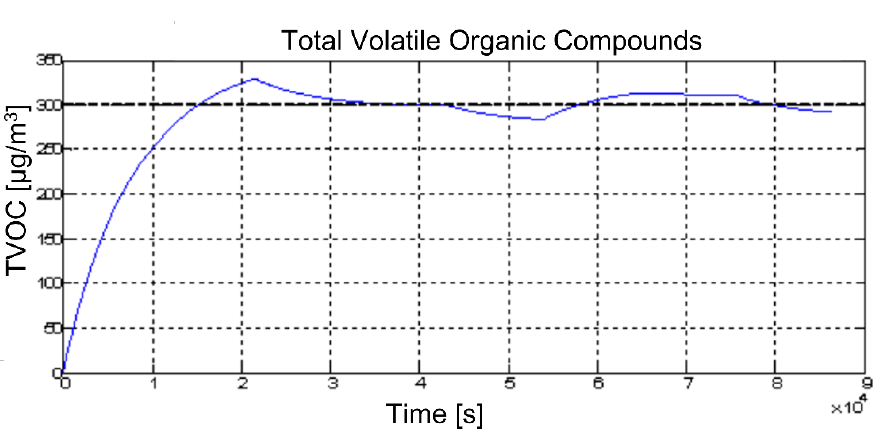
Figure 17. Modelization results on IAQ variables: HCHO.